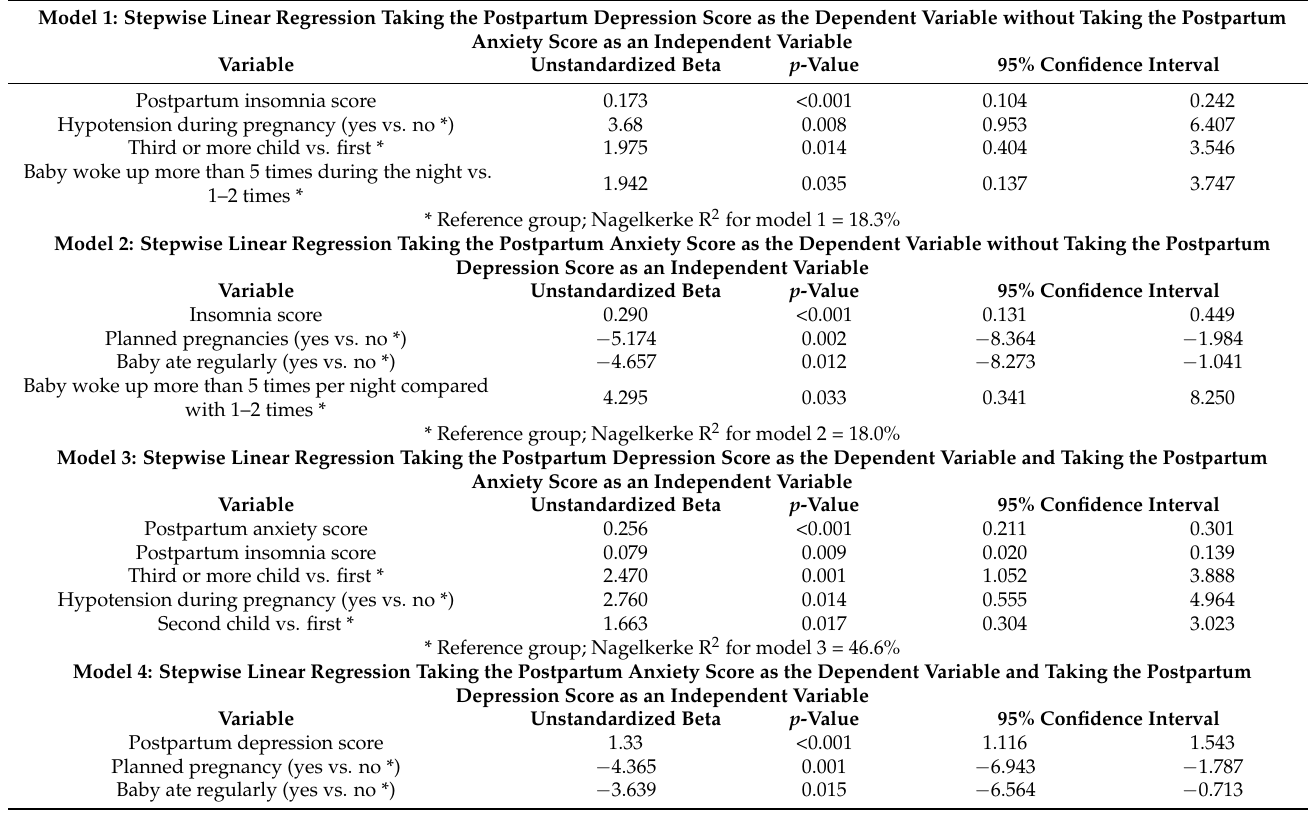
Table 6. Multivariable